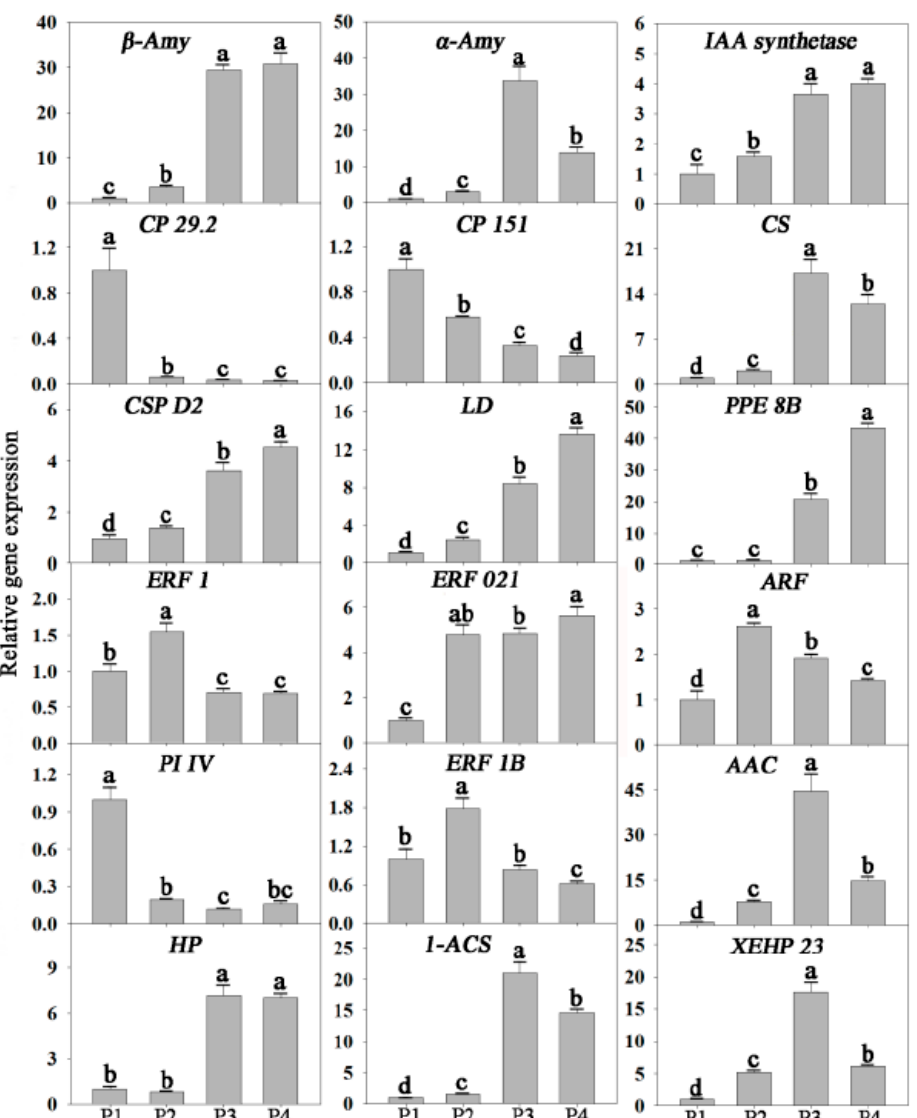
Figure 3. Validation of RNA-seq results by quantitative reverse transcription polymerase chain reaction (qRT-PCR). Eighteen di ff erentially expressed genes related to signal transduction, transcription factors (TFs), photosynthesis, cell wall, starch, energy, respiration, and other metabolisms were selected for quantitative real-time PCR analysis. b-Amy, beta-amylase 3; a-Amy, alpha-amylase; GH 3.8, probable indole-3-acetic acid-amidosynthetase GH3.8; ARF, auxin-responsive family protein; ERF 021, putative ethylene-responsive transcription factor ERF021; ERF 1, putative ethylene-responsive transcription factor 1; CP 29.2, chlorophyll a-b binding protein CP29.2, chloroplastic; CP 151, chlorophyll a-b binding protein 151, chloroplastic; CS, citrate synthase; AAC, ADP, ATP carrier protein, mitochondrial; ERF 1B, ethylene-responsive transcription factor 1B; PI IV, Photosystem I reaction center subunit IV, chloroplastic; CSP D2, cellulose synthase-like protein D2; LD, Leucoanthocyanidin dioxygenase; PPE 8B, pectinesterase / pectinesterase inhibitor PPE8B; XEHP 23, xyloglucan endotransglucosylase / hydrolase protein 23; 1-ACS, 1-aminocyclopropane-1-carboxylate synthase; HP, Hypothetical protein. Values with di ff erent letters are significantly di ff erent ( p < 0.05).